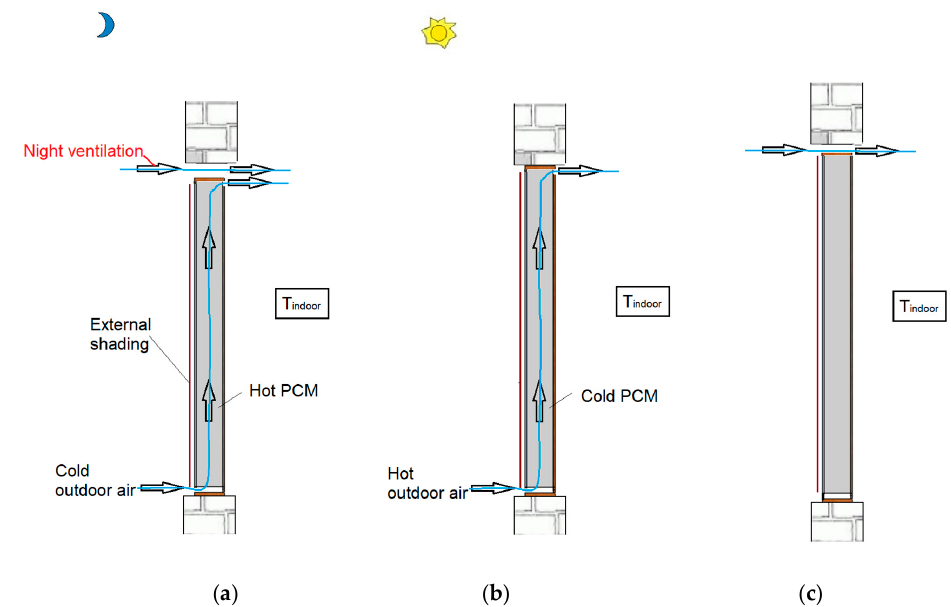
Figure 4. The working principle of the PCM façade in summer. ( a ) PCM discharge mode, when (hour < 7) or (hour > 20:00). ( b ) Ventilation pre-cooling mode, when T indoor > 24 °C . ( c ) Bypass ventilation, when T indoor < 24 °C .